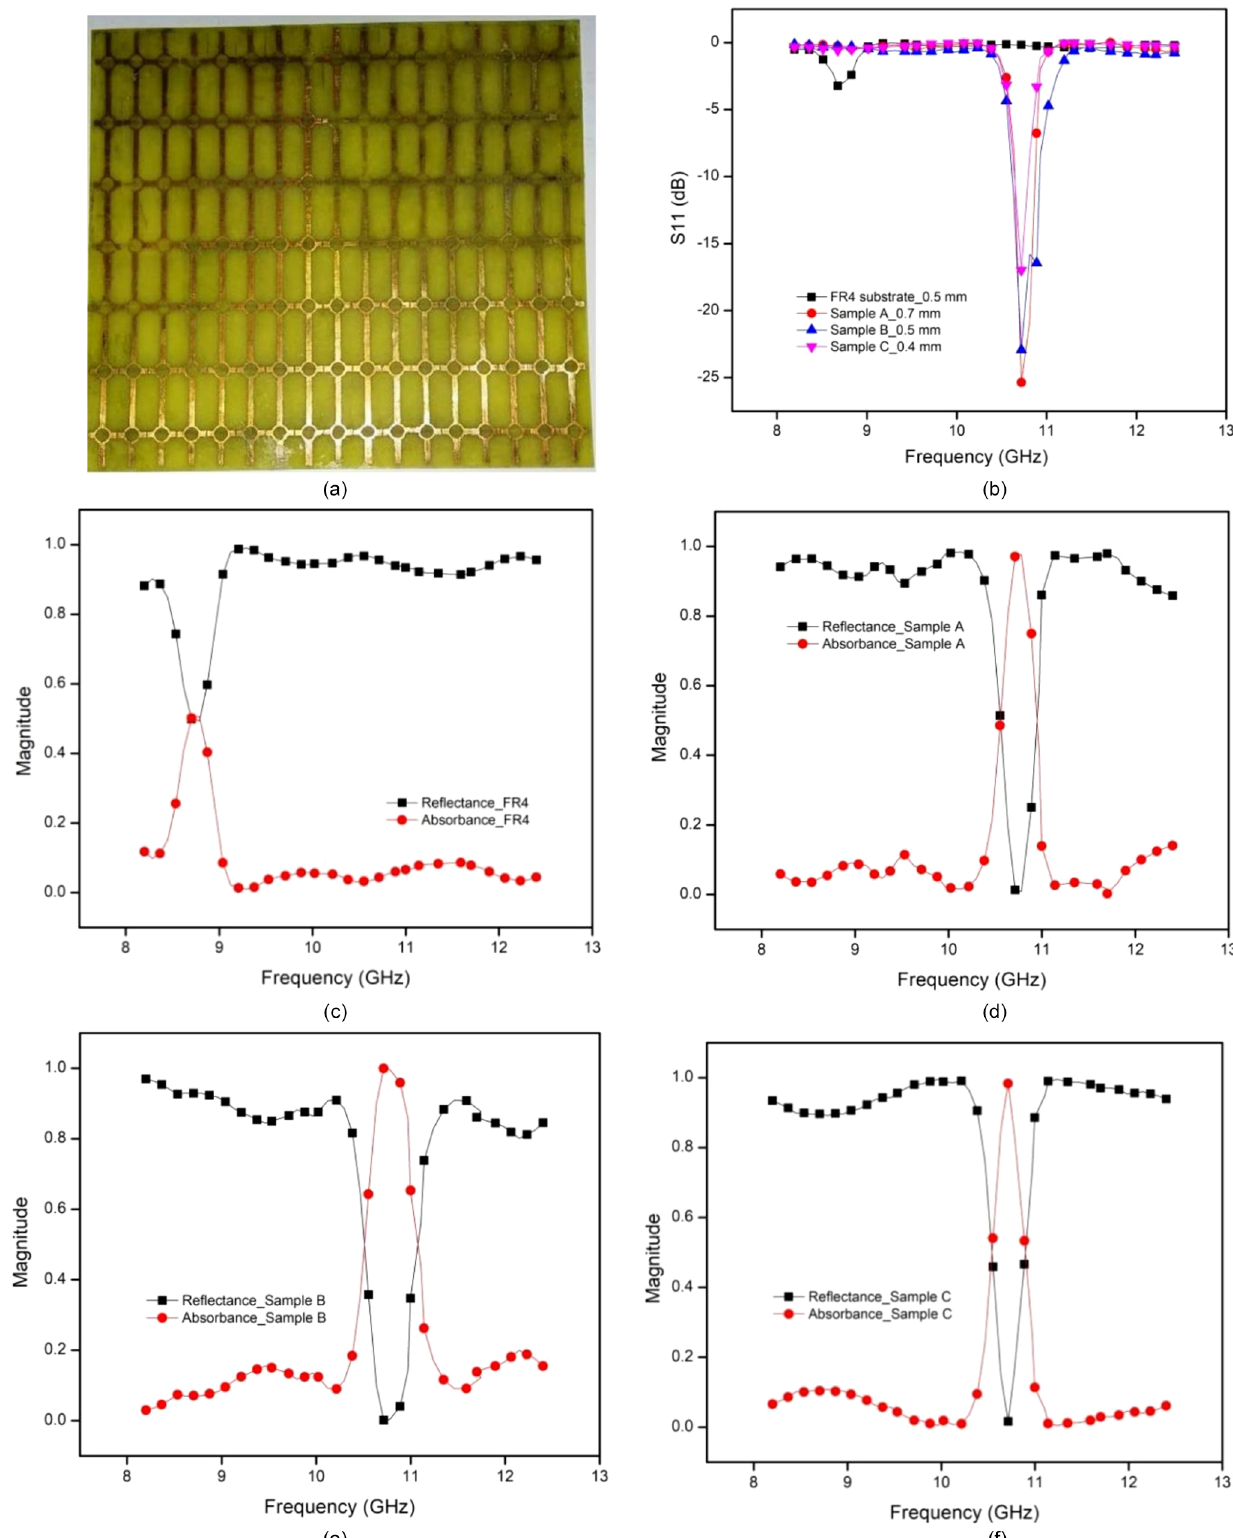
Fig. 7. (a) Fabricated sample, (b) measured S11 ( v ) values, (c – f) re fl ectance and absorbance of the proposed